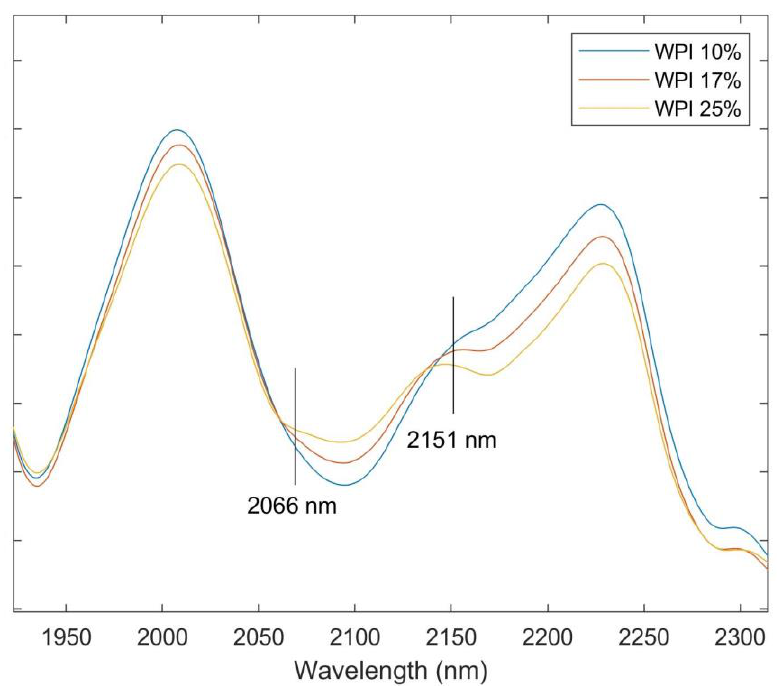
Figure 3. A section of spectra from samples formulated with three WPI concentrations (10%, 17%, and 25%), preprocessed with SNV and SG.